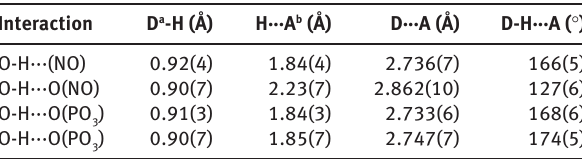
Table 1 Geometry of hydrogen